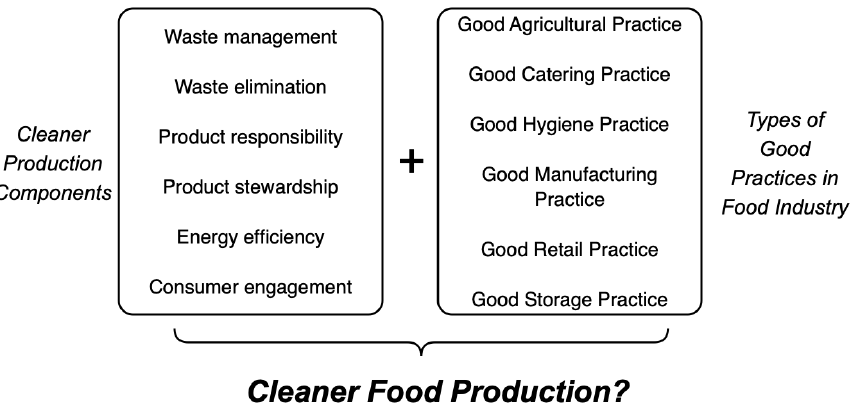
Figure 4. Could it be possible for cleaner production components and types of good practices in the food industry to either combine or at least meet to form “ cleaner food production”